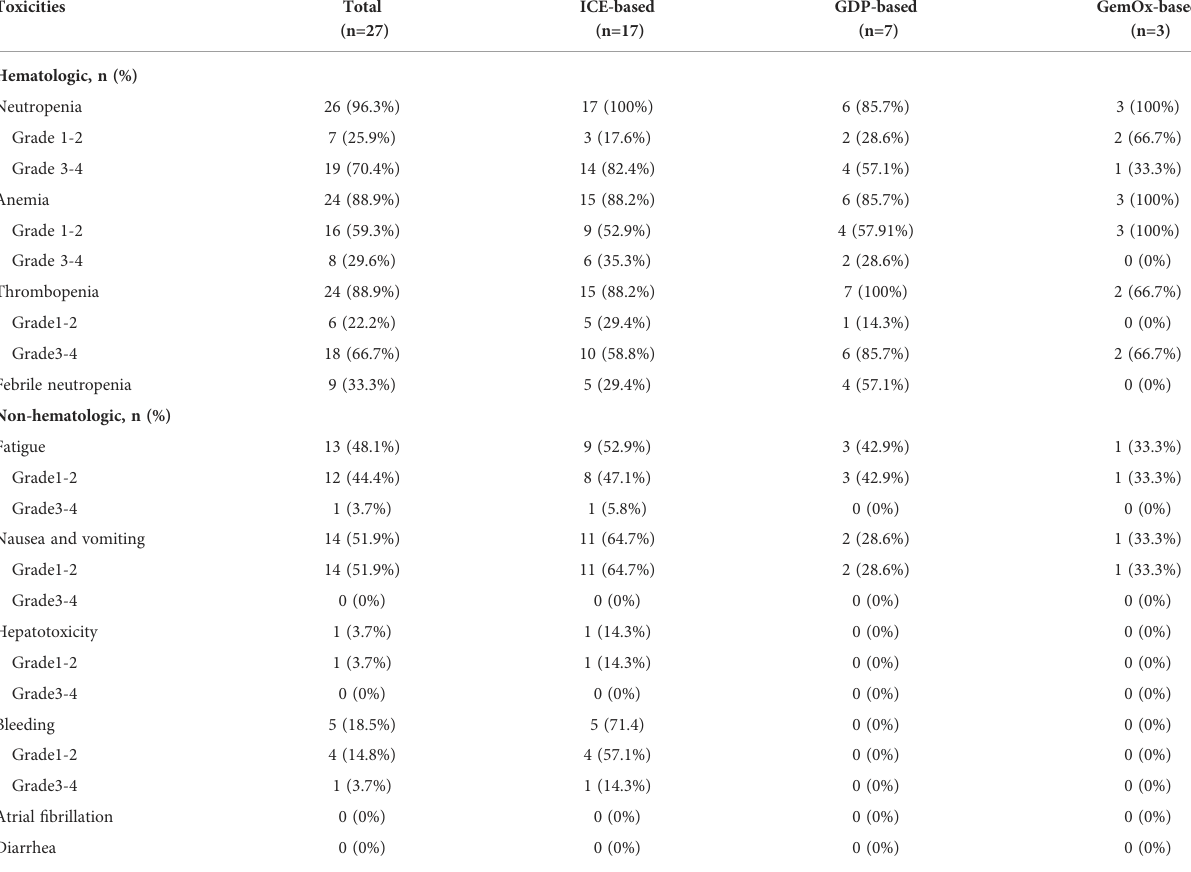
TABLE 3 Main adverse effects by treatment group.